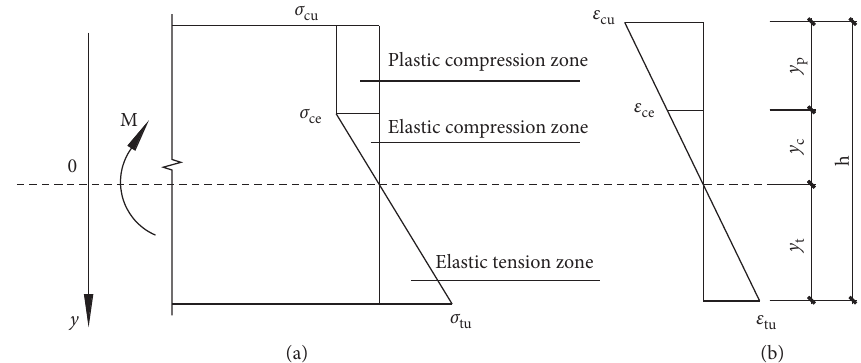
Figure 7: Diagrams of the stress and strain over the moment section. (a) Stress diagram. (b) Strain